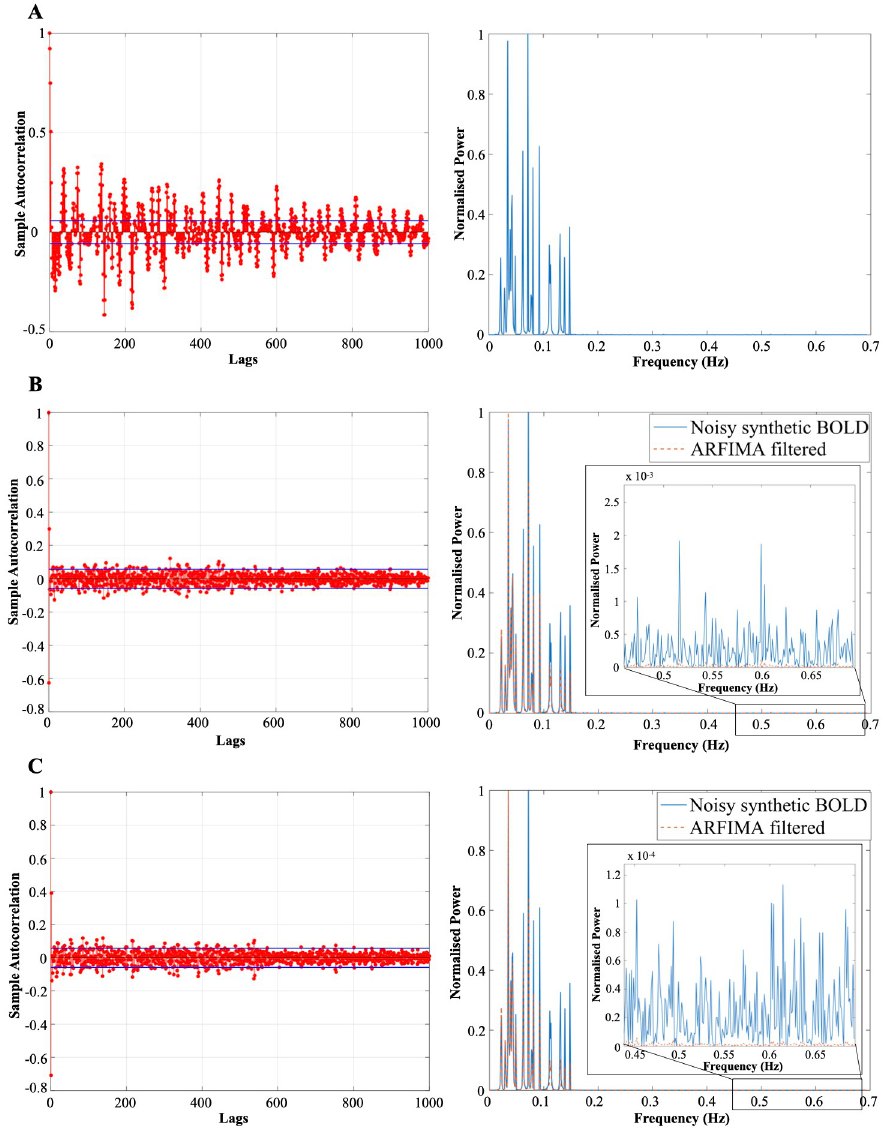
Fig 4. Autocorrelation and normalised power spectrum plots of unfiltered and filtered synthetic BOLD signal. (A) The designed synthetic BOLD signal with a sampling frequency of 1.3889 Hz (similar to the sampling rate of rs-fMRI HCP dataset) which has inverse power law autocorrelation plot (left panel) (similar to the observed original resting- state BOLD signal). The synthetic BOLD signal thus created consists of low frequency fluctuations in the range of 0.01 − 0.15 Hz (similar to the observation about intrinsic BOLD fluctuation in the resting brain in [9, 42, 43]), right panel. An artificial white noise is added to the created synthetic BOLD signal. (B) The left panel shows the sACF of the fractionally differenced ( d = 2.6) synthetic BOLD signal (with white noise, WN (0, 100)). The right panel shows the normalised power spectrum plot of unfiltered dummy BOLD signal (cyan curve, WN (0, 100)) and the ARFIMA (1, 2.6, 0) filtered BOLD signal (dashed orange curved) embedded with zoomed in plot at higher frequency. (C) The sACF of the fractionally differenced ( d = 3.8) synthetic BOLD signal (with white noise, WN (0, 10)) and normalised power spectrum plot of unfiltered dummy BOLD signal (cyan colored curve, WN (0, 10)) and the ARFIMA (1, 3.8, 0) filtered BOLD signal (dashed orange curve) embedded with zoomed in plot at higher frequency is depicted in the left and right panel